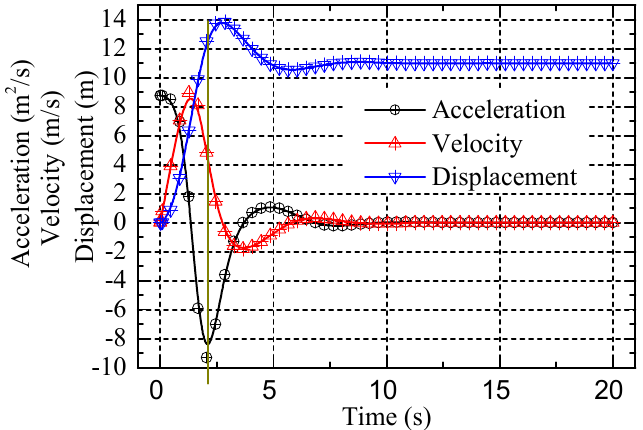
Figure 10. Variation of the acceleration, velocity and displacement of the corer during penetrating.